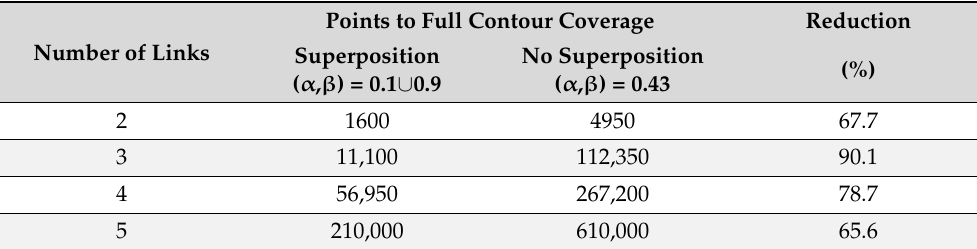
Table 1. Comparison of superposition and no superposition for the minimal number of points needed to achieve 99% coverage. Points to Full Contour Coverage